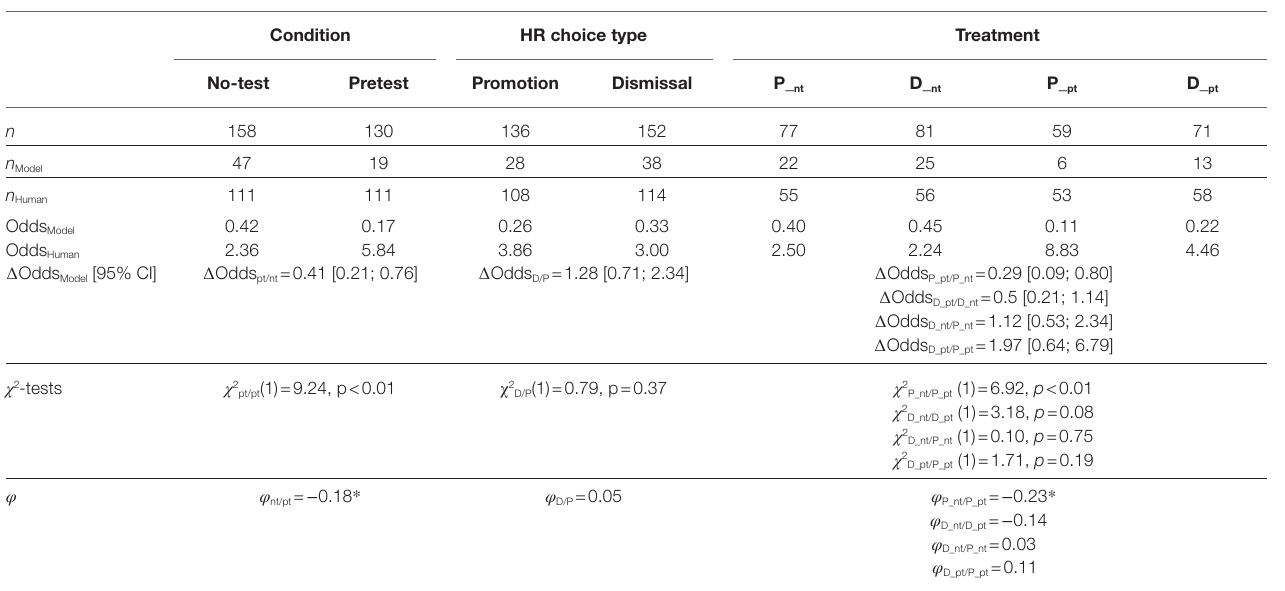
TABLE 2 | Odds ratios, χ 2 -, and φ -tests of choice by condition, type, and treatment. Condition HR choice type Treatment No-test Pretest Promotion Dismissal P_ nt D_